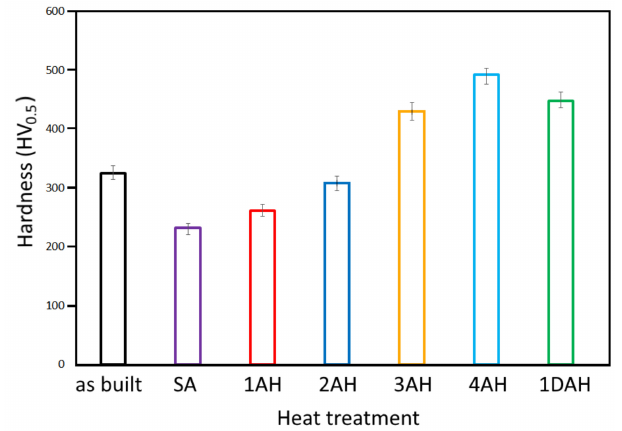
Figure 7. The average values of Vickers hardness in micro-LPBF Inc718 samples before and after different heat treatment